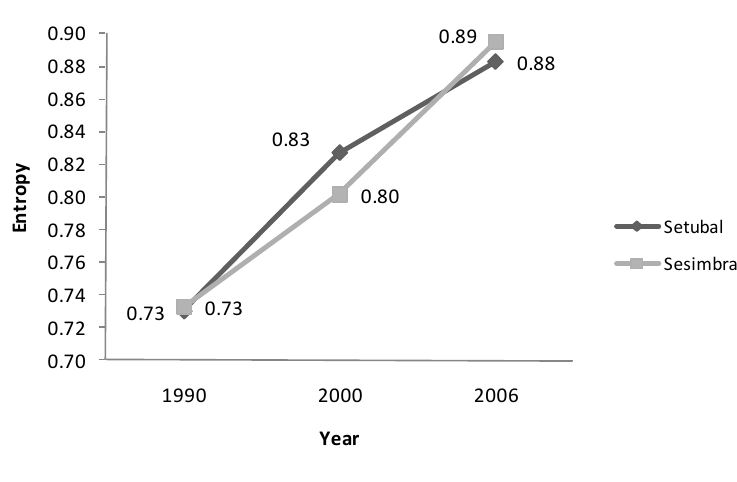
Figure 3. Urban sprawl measurement.